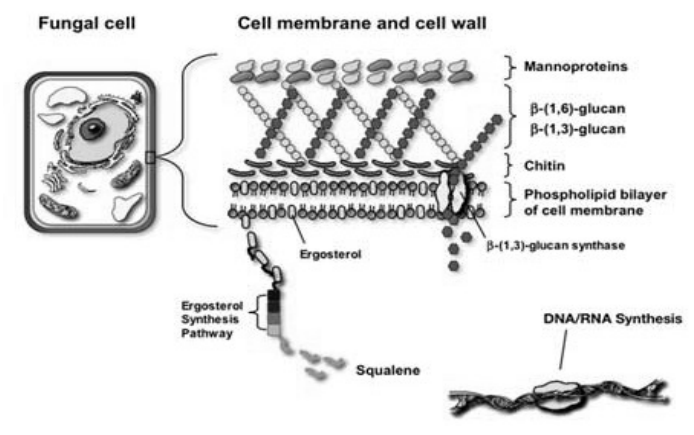
Figure 3. Fungal cell